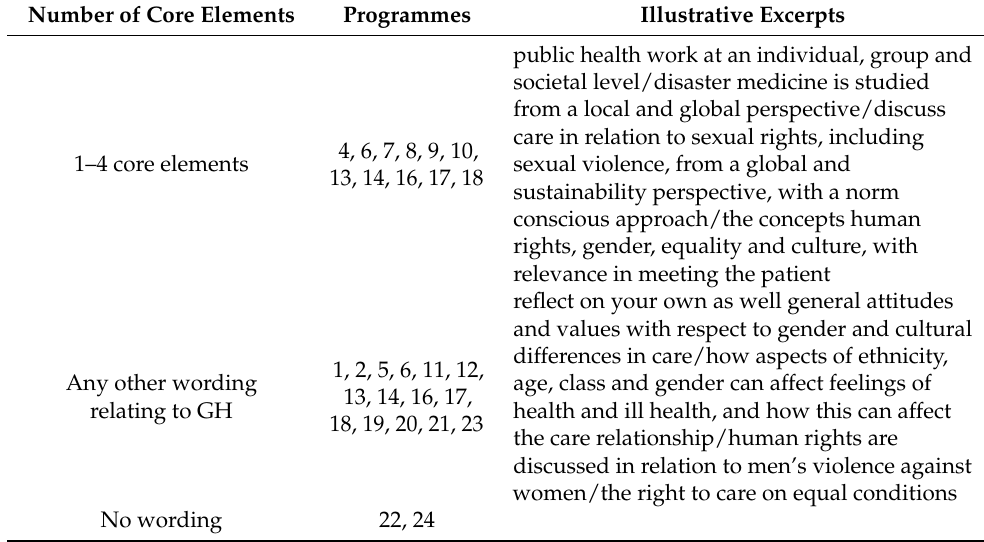
Table 6. Syllabi grouped under the heading